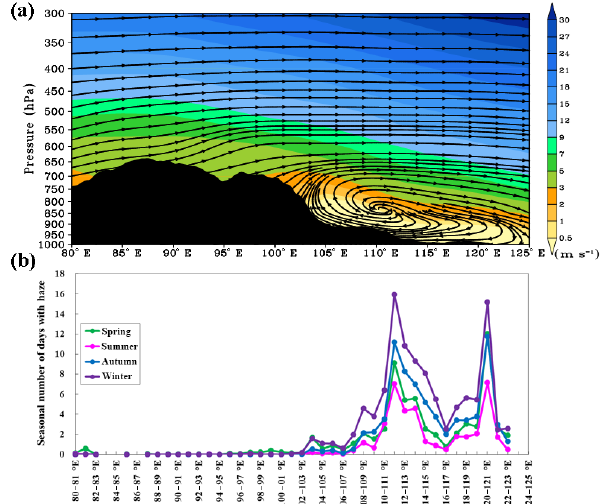
Figure 2. Cross sections of vertical circulations illustrated by stream lines (a) with the horizontal wind speed (ms − 1 ; color con- tours) and zonal variations in annual haze event frequency (b) at 27– 41 ◦ N averaged in spring, summer, autumn and winter over 1961– 2012. Note that near-surface vertical and horizontal winds are not illustrated well here due to north–south variations in the terrain and approximation of the location of the plateaus (black shaded area) in panel (a) . All fields are for the annual